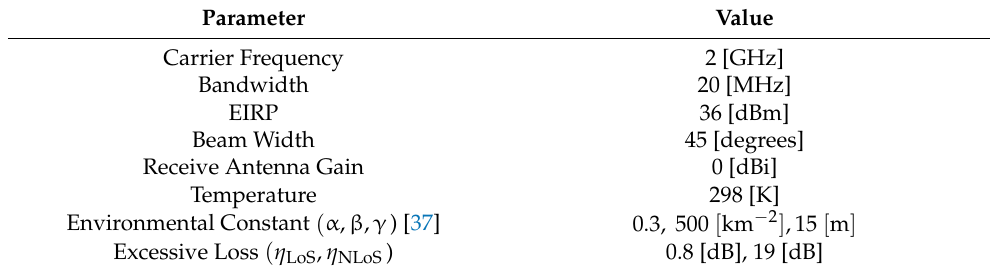
Table 2. Microwave band parameters.